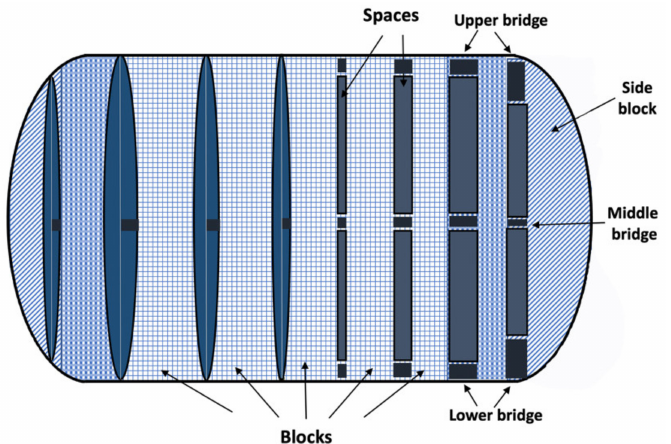
Figure 4. Immediate release theophylline gaplets. The novel design is based on nine repeating units (blocks) joined together by three bridges. The capsule-like general shape was maintained by using curved side units [76].